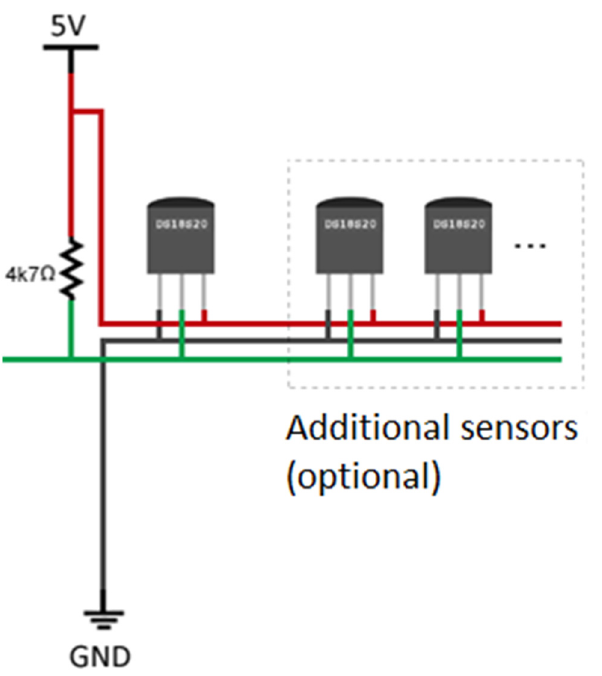
Figure 10. DS18B20 sensor connection diagram to the 1-wire bus.